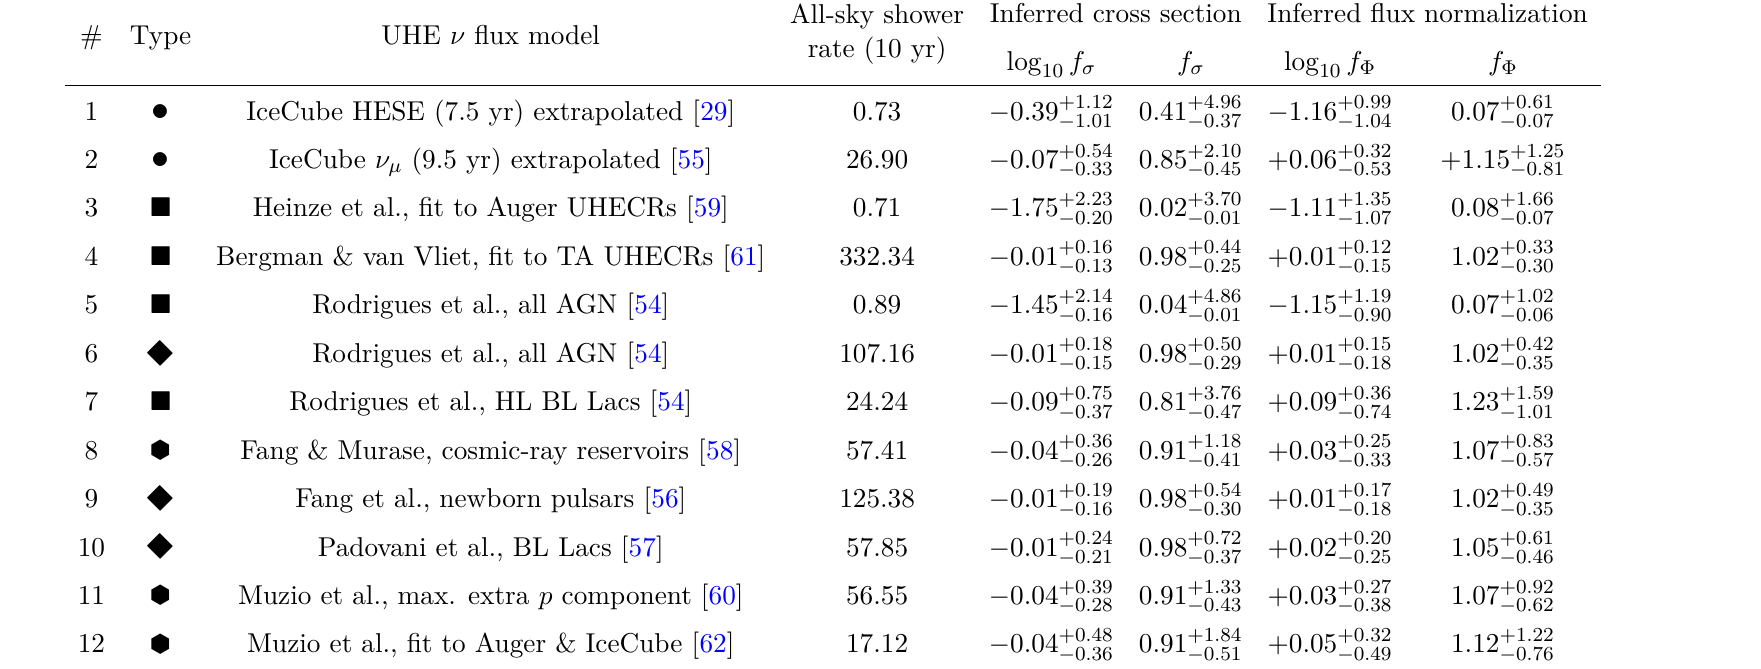
Table 2 . Expected rates of neutrino-induced showers and measurement capability of the cross section and flux normalization in the radio component of IceCube-Gen2, after T = 10 years of exposure time, for the benchmark UHE diffuse neutrino fluxes used in this analysis; see section 4. Possible flux types are: extrapolation to ultra-high energies ( • ), cosmogenic ( (cid:4) ), source ( (cid:4) ), and cosmogenic + source ( (cid:146) ). Measurement capabilities are expressed in terms of f for the cross section, and f Φ Φ for the flux normalization at a neutrino energy of 10 8 GeV. The real σ ≡ σ/σ std Φ ≡ 0 / 0 , std values are f = 1 and f = 1 . Results are obtained using the baseline choices for the detector resolution: shower energy resolution of σ = 0 . 1 , with σ Φ (cid:15) ( E rec = 2 ◦ ; see section 6.4 for details. The shower rates shown are all-sky, i.e., summed over all values (cid:15) ≡ log /E sh ) , and angular resolution of σ θ 10 sh z of reconstructed direction, − 1 ≤ cos θ rec ≤ 1 , and binned in a single bin of reconstructed shower energy, 10 7 ≤ E rec / GeV ≤ 10 10 . However, all-sky z sh rates are only referential, and in the statistical analysis used to infer the cross section and flux normalization, we use instead binned shower rates; see section 7.4 for details. For the inferred cross section and flux normalization, we show the best-fit values and 68% credible intervals of their one-dimensional marginalized posteriors. The statistical procedure returns results for log f σ and log f Φ ; we show the corresponding results in 10 10 terms of f and f to facilitate their σ Φ